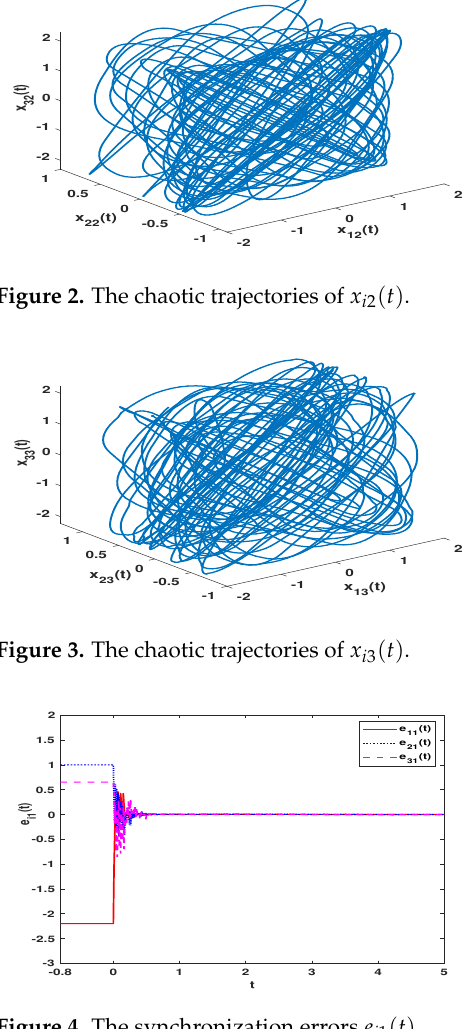
Figure 4. The synchronization errors e i 1 ( t ) .